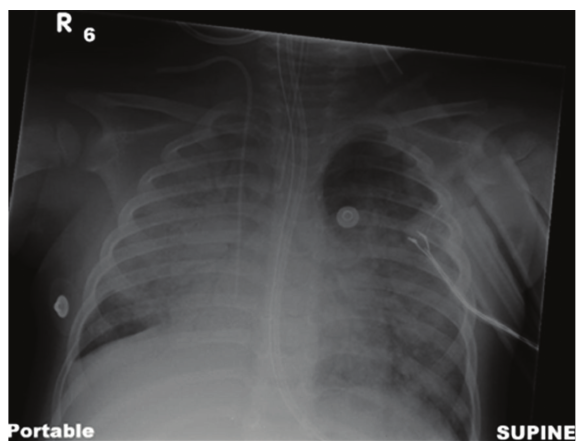
Figure 1: Initial chest radiograph prior to ECMO